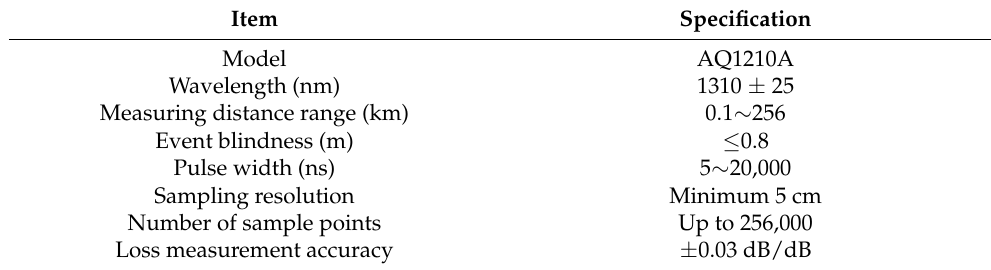
Table 1. System parameters.